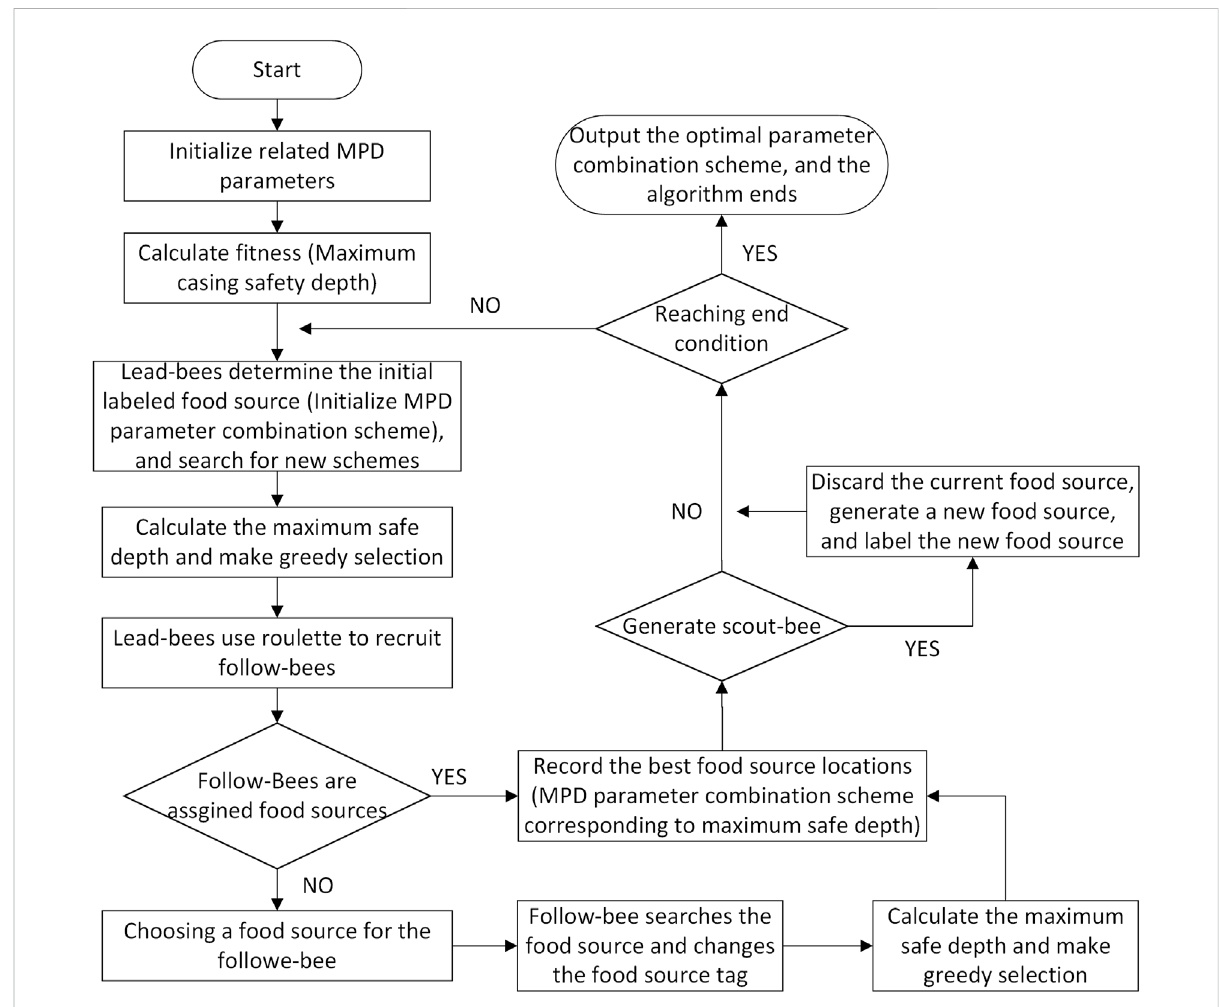
FIGURE 6 Schematic diagram of wellbore ECD distribution and determination of maximum casing depth under different pressure control parameters in open hole section.